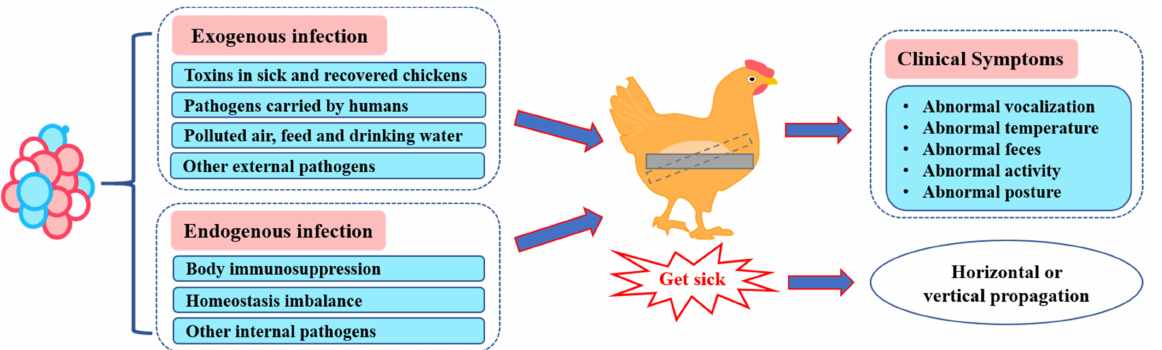
Figure 1. The route of infection and possible clinical symptoms of poultry diseases. Disease infection in poultry can be divided into endogenous and exogenous infection according to the pathogen source. Poultry diseases may cause clinical physiological and behavioral changes and these diseases may be transmitted horizontally or vertically in the